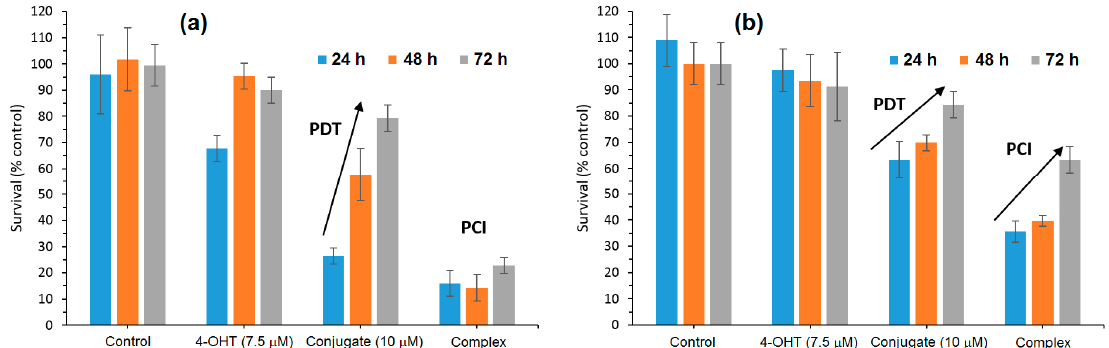
Figure 30. Photocytotoxicity to ( a ) breast adenocarcinoma (MCF7) and ( b ) breast human carcinoma (MDA-MB-231) cells following overnight (16 h) incubation with medium only (Control), tamoxifen (4-OHT) (7.5 µM), mTHPP- β -CD conjugate (10 µM), and mTHPP- β -CD(10 µM)-4-OHT(7.5 µM) complex. Adapted from Theodossiou; Goncalves; Yannakopoulou; Skarpen; Berg [146].